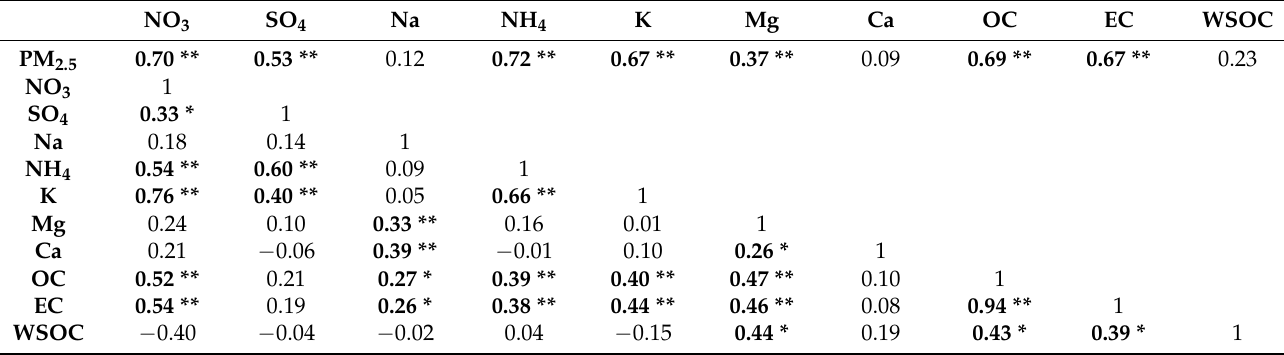
Table 5. Pearson correlation coefficients between PM 2.5 components in LC samples. Number in bold with two starts and with one star indicate that the correlations were significant at the 0.01 and 0.05 levels,